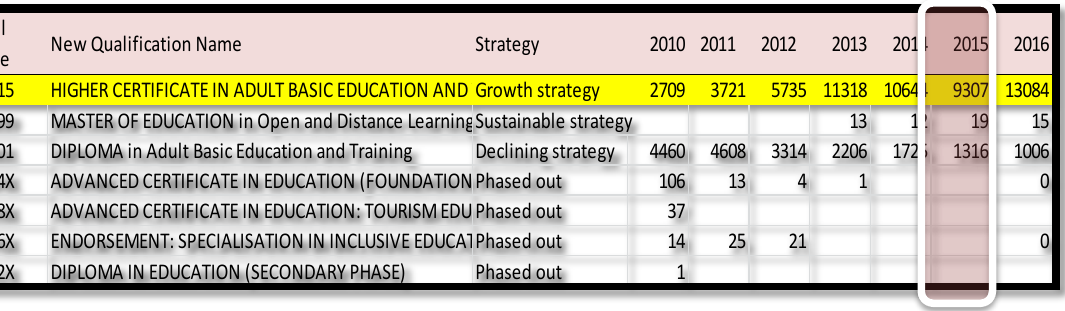
Figure 5. Excerpt of Qualification History and Targets Set for